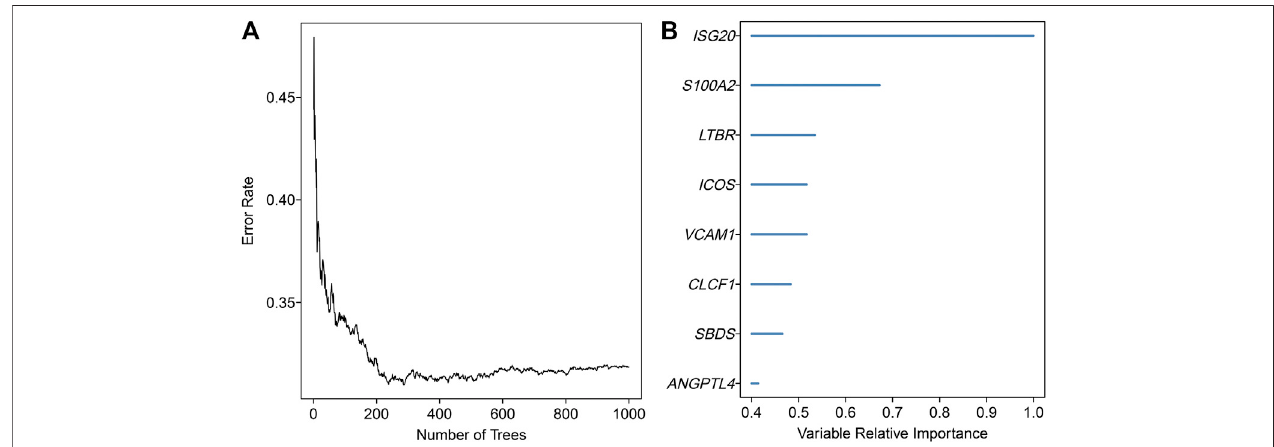
FIGURE1| Randomsurvivalforestsvariablehuntinganalysis. (A) Therelationshipbetweenthenumberofclassi fi cationtreesandtheerrorrate.Thisrandomforest consisted of 1,000 decision trees and analysed all the signi fi cant survival-related genes in univariate Cox-regression analysis. (B) Out-of-bag importance of the survival- related genes with values over 0.4. The x -axis represented the relative importance values of variables estimated by random